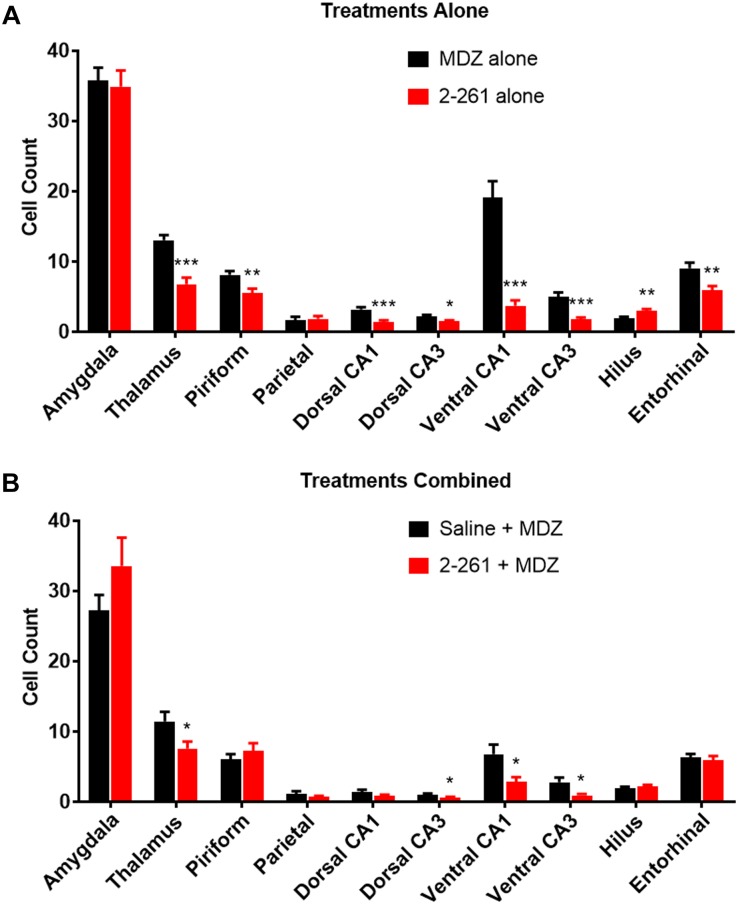
Effect of treatment by 2-261 alone (A) or combined with MDZ (B) on Fluoro-Jade B labeled neurons in various brain regions removed from subject rats 24 h after receiving diisopropyl fluorophosphate challenge. Asterisks indicate brain regions in which there was a significantly different response (∗p < 0.05, ∗∗p < 0.01, ∗∗∗p < 0.001) between treatment groups in the number of Fluoro-Jade B stained neurons as measured by t-test, N = 17–20 rats for each treatment group. MDZ, midazolam.